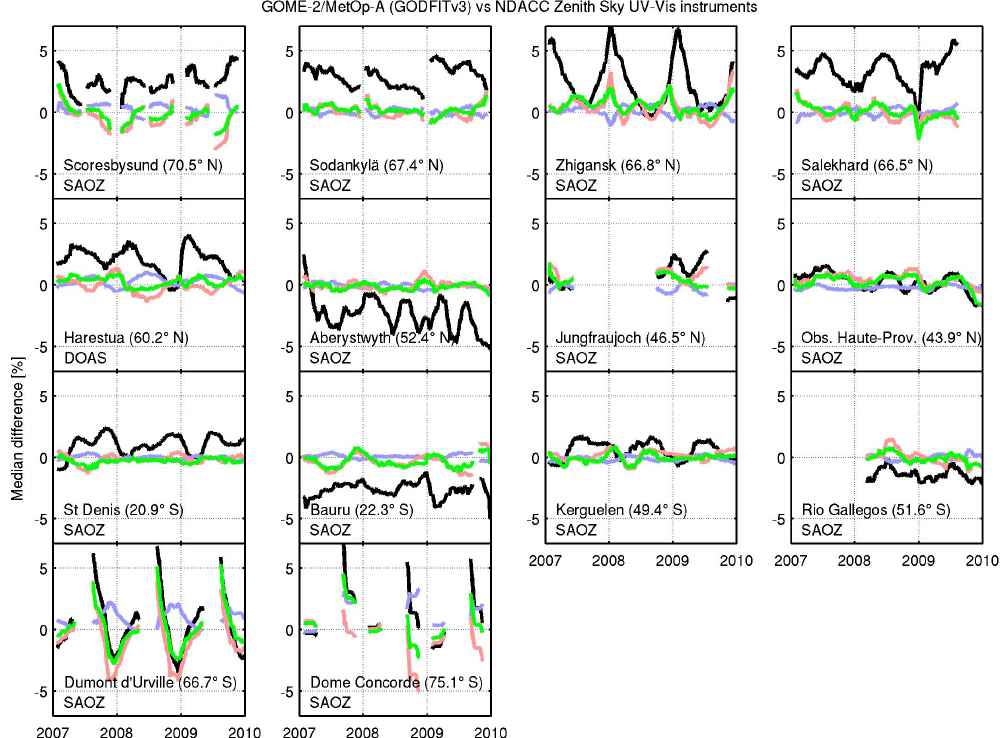
Figure 17. Similar to Fig. 16 but for the median of the